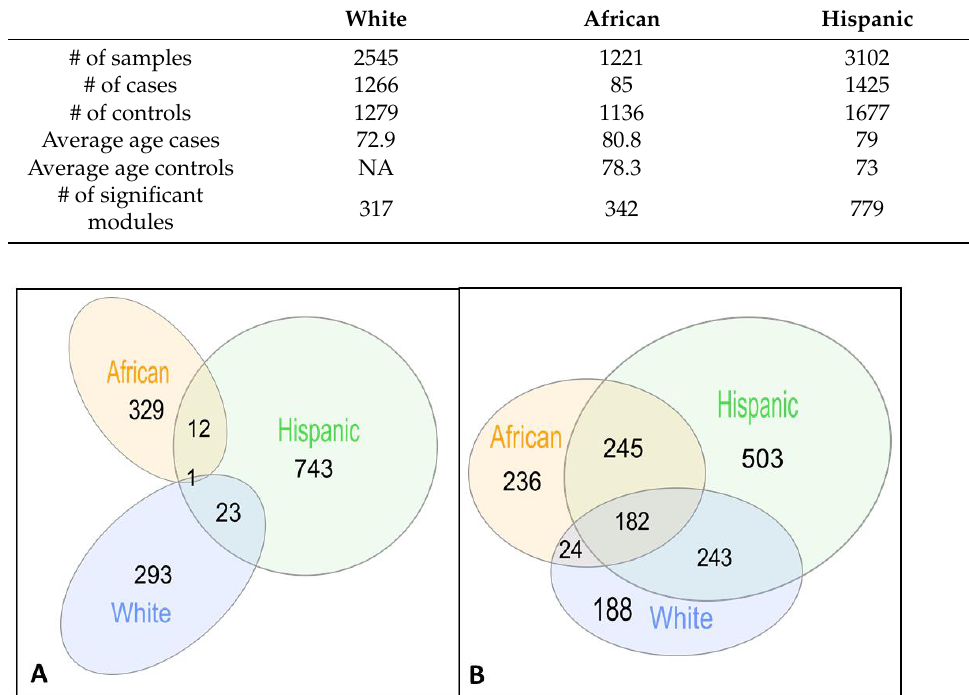
Figure 2. Venn diagrams of shared gene modules ( A ) and shared genes ( B ) between populations.